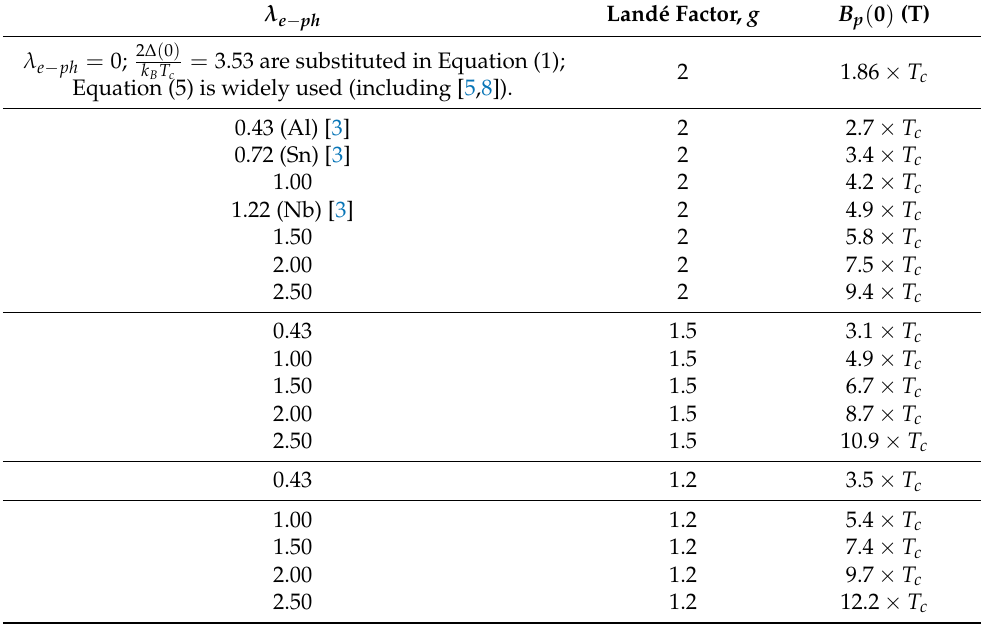
Table 1. Calculated Pauli limiting field, B p ( 0 ) , for s -wave superconductors in accordance with Equations (1) and (10). Values for metals (Al, Sn, and Nb) are included. λ e − ph Landé Factor, g B p ( 0 ) (T) ∆ ( 0 ) = 3.53 are substituted in Equation (1); λ e − ph = 0; 2 k B T c Equation (5) is widely used (including